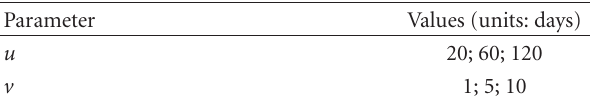
Table 2: The design for the first